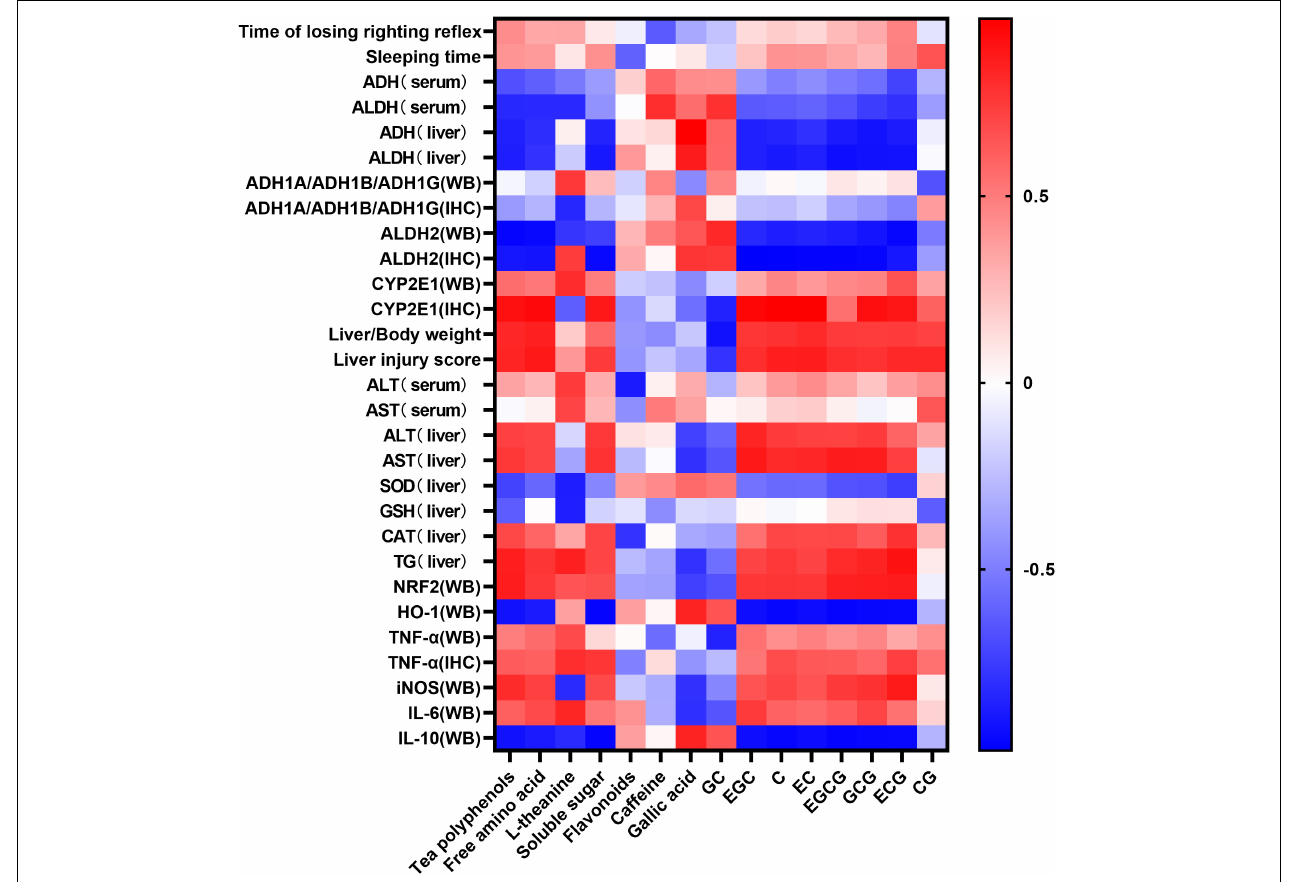
FIGURE 9 | Heat map of composition of the six types of tea and related indicators of acute alcoholism. Blue and red represent negative correlation and positive correlation, respectively.